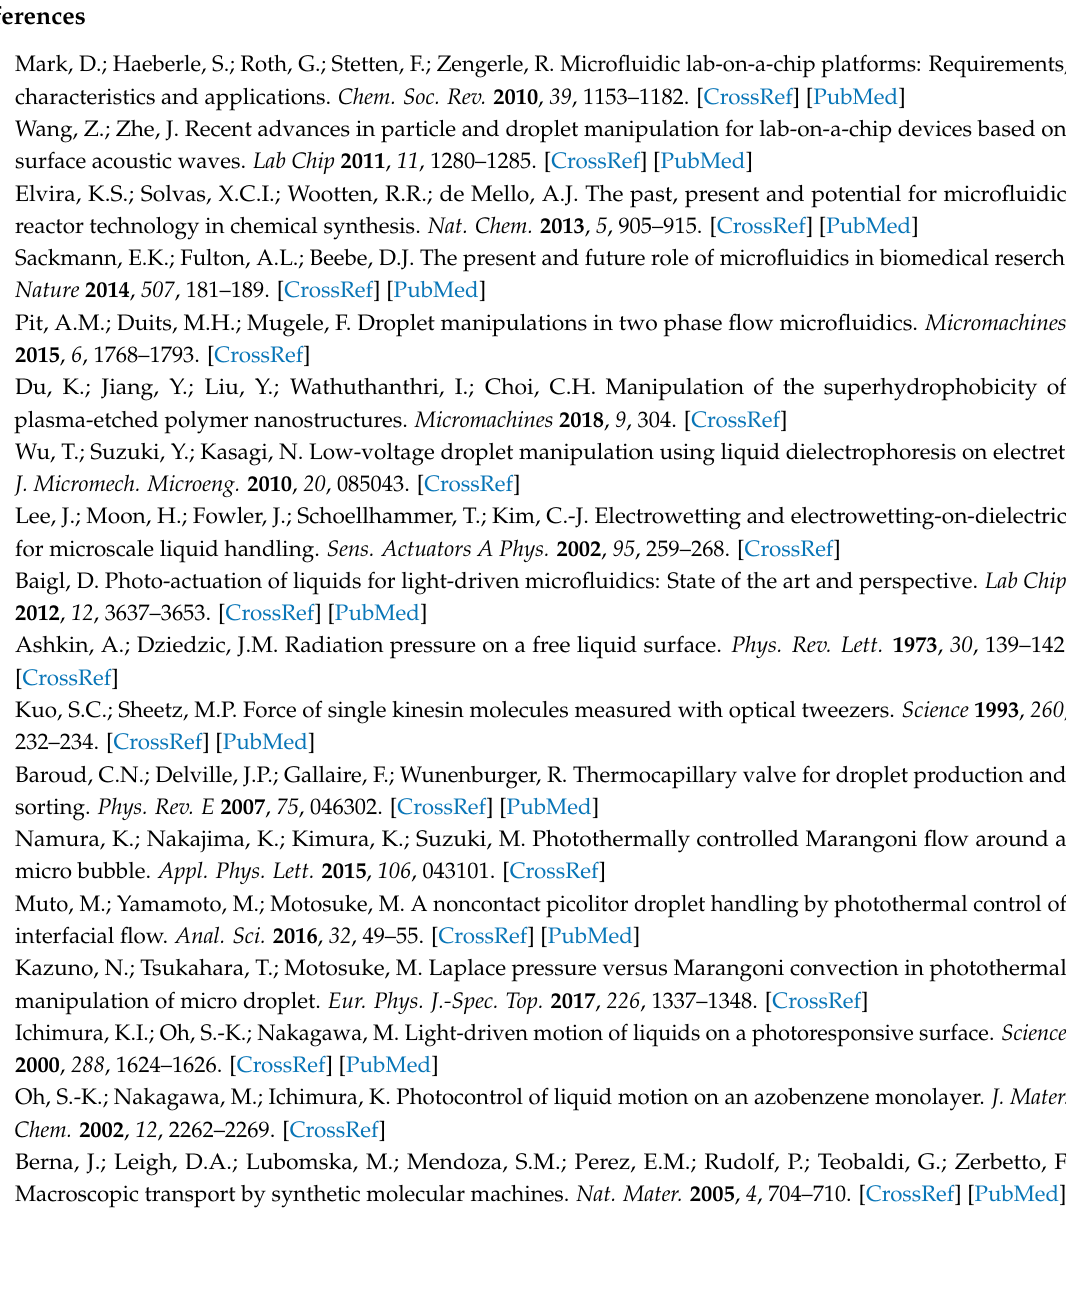
Figure A5. Temporal variation of the wet length of the droplet with the cis-trans photoisomerization by UV-light irradiation. The red line is a numerical result, while the black dashed line is a theoretical solution expressed by Equation